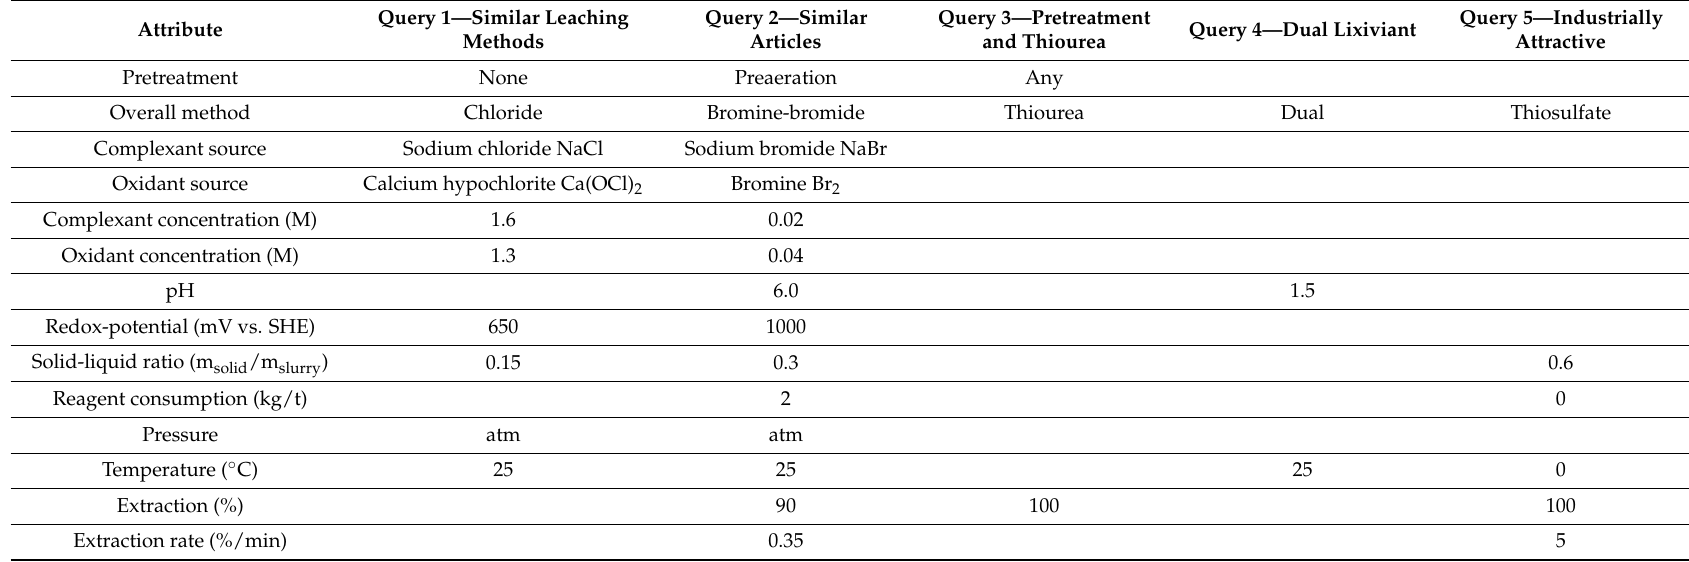
Table 4. Queries 1–5 for testing the LeachSim